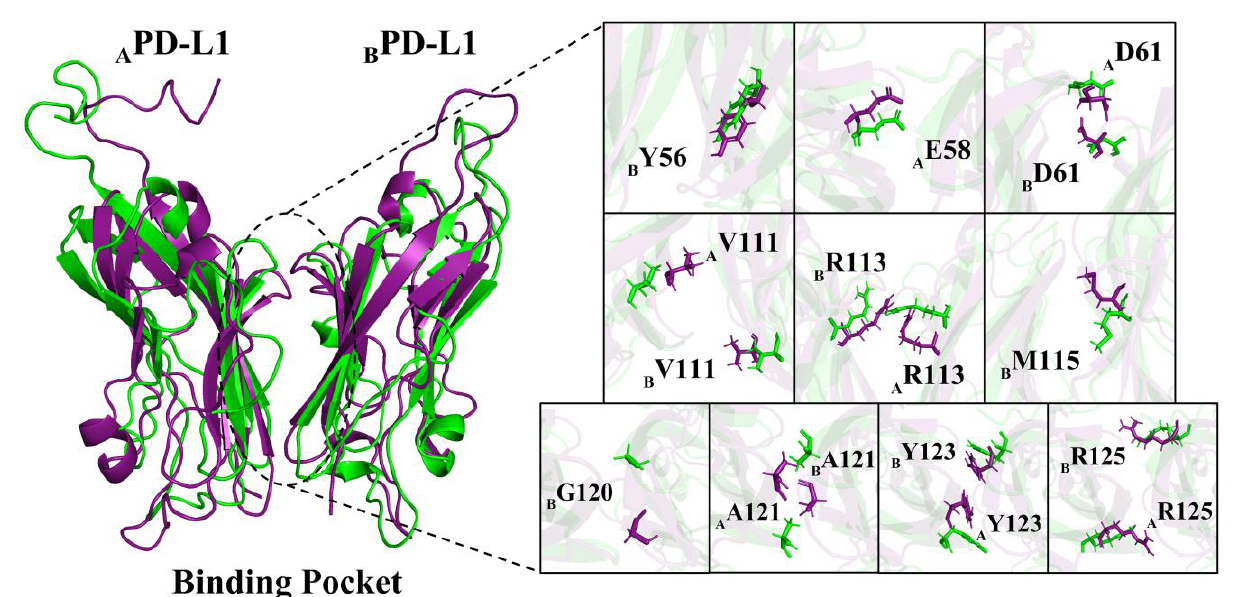
Figure 10. Residues with evident conformational changes in the dimer (purple) and S (green) systems.